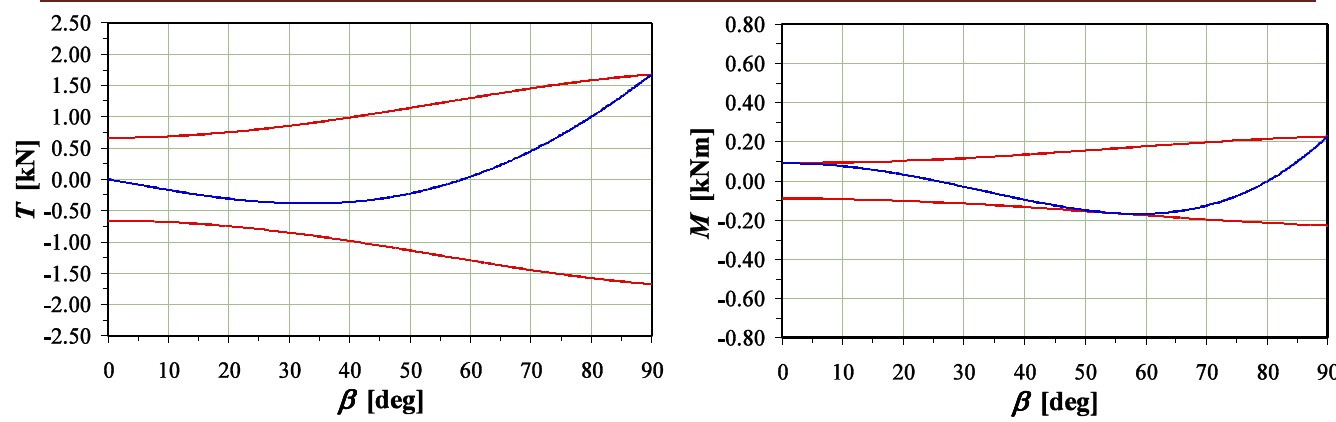
Figure 5: Numerical optimisation results for the trends of shear T (  ) and moment M (  ) at friction coefficient  = 0.3959.